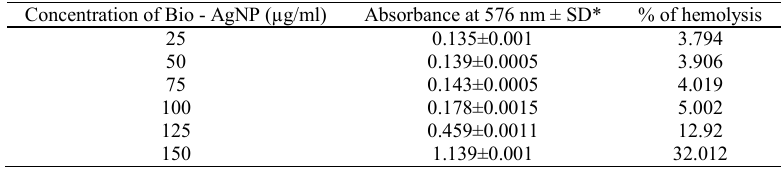
Table 3 Dose dependent RBC lysis assay of Bio – AgNP Table 3. Dose dependent RBC lysis assay of Bio – AgNP Concentration of Bio - AgNP (µg/ml)